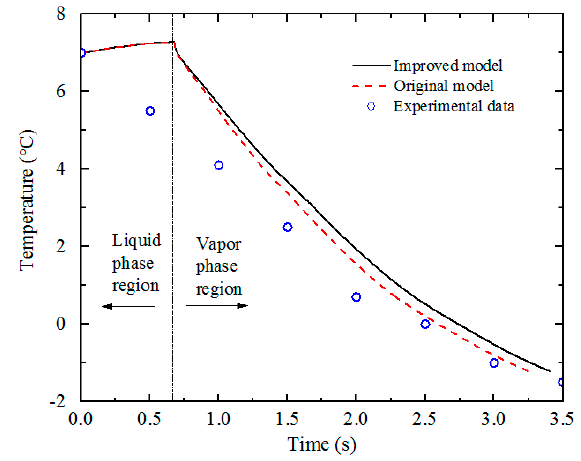
Figure 6. Comparison between experimental and simulated temperatures in the tank. The experimental data were taken from Botterill et al. [39].